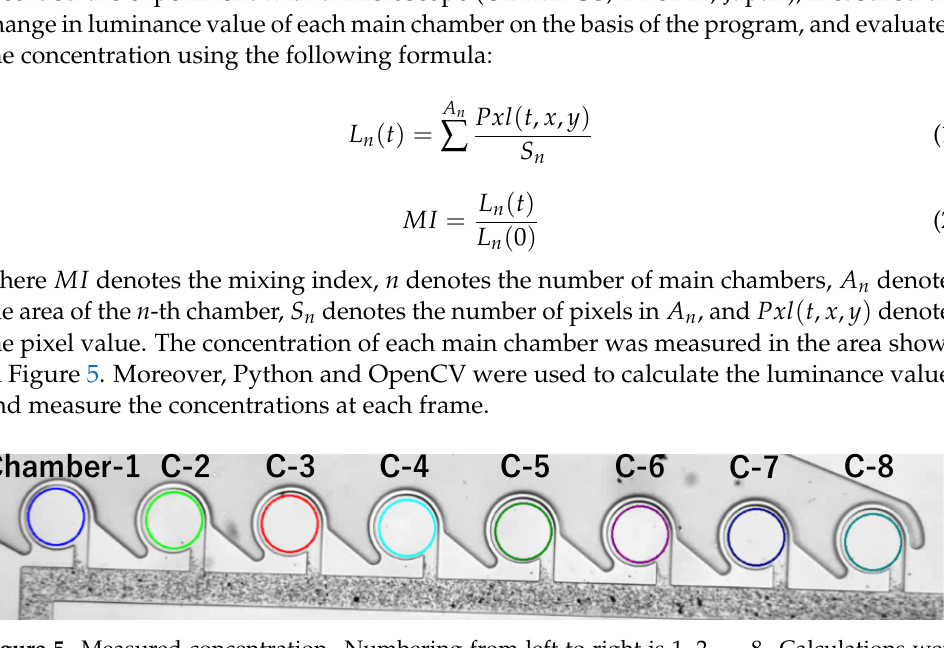
Figure 5. Measured concentration. Numbering from left to right is 1, 2, ..., 8. Calculations were performed using Python and